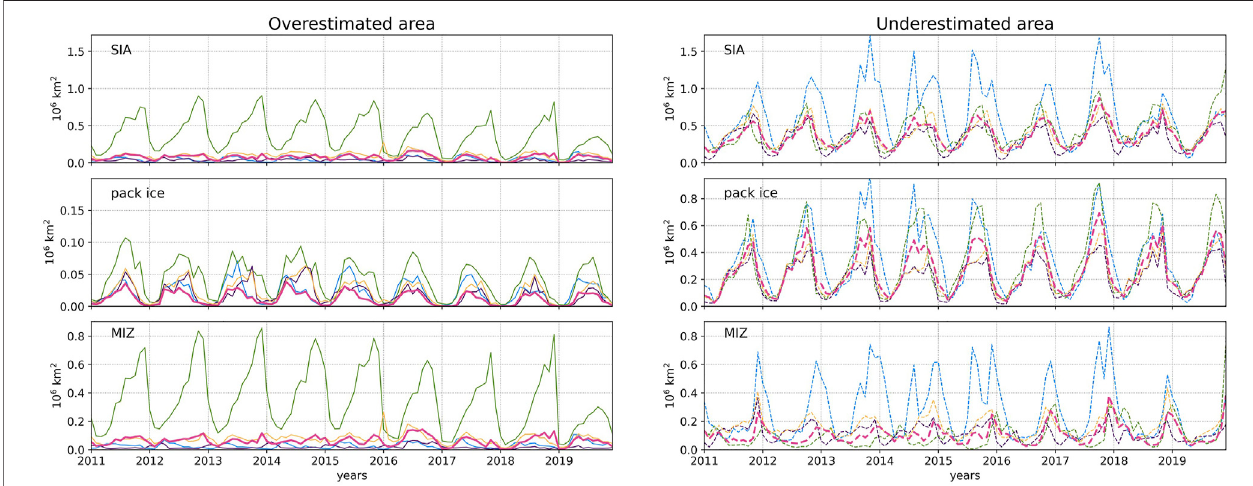
FIGURE 3 | Time series of the GREP integrated ice area error components (in magenta) calculated with respect to CDR for total SIA (top panel), pack ice (middle panel) and the MIZ (bottom panel). Area of sea ice where GREP simulates higher (lower) SIC is on the left (right) column. The y -axis scales for pack ice are different. Thin lines represent the individual ORAs: CGLORS in light blue, FOAM-GloSea5 in violet, GLORYS2 in green, and ORAS5 in yellow – the same colors will be used in the following fi gures for single ORAs.